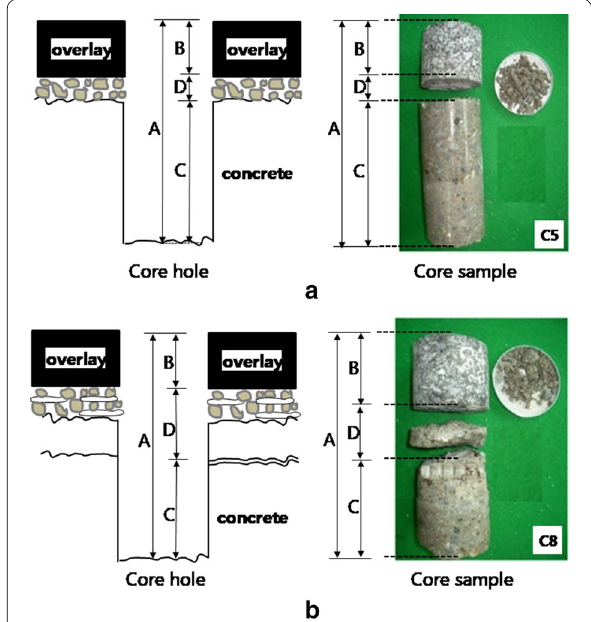
Fig. 6 Illustration of criteria in the estimation of the deteriorated depth from core samples with: a scaling and decomposition of concrete constituents, and b with delamination.